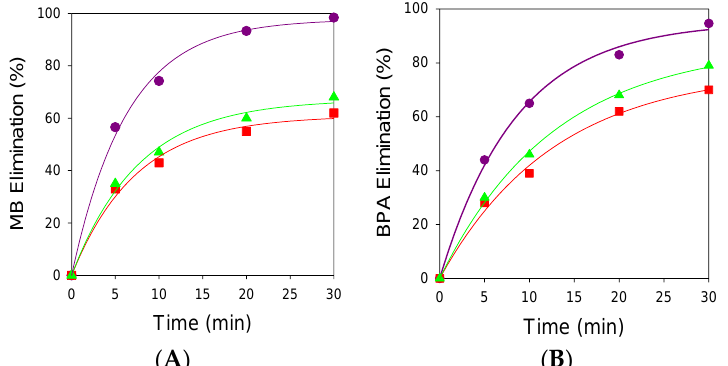
Figure 6. MB ( A ) and BPA ( B ) elimination (20 mg/L) at a catalyst concentration of 800 mg/L with pseudo-first order kinetics adjustment (line) in wastewater that just received a primary treatment (red squares), that received a secondary treatment (green triangles), and Milli-Q water (purple circles).